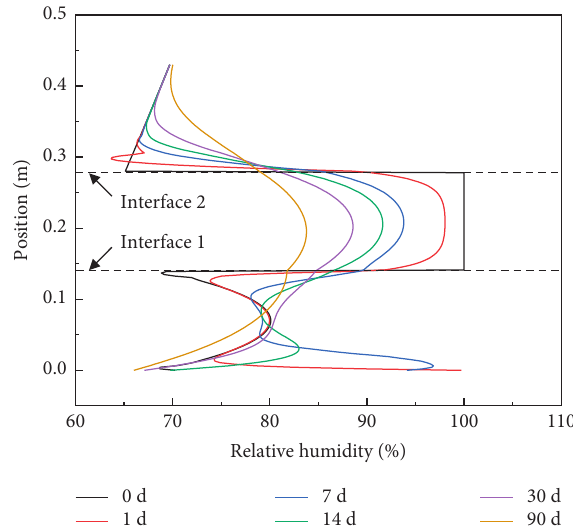
Figure 18: Distribution of RH along the path